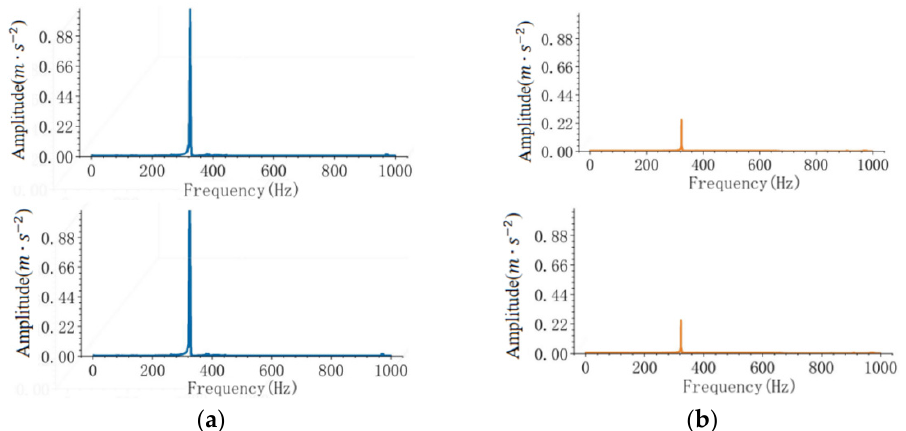
Figure 14. Sparse decomposition simulation amplitude/envelope results. ( a ) sparse decomposition amplitude map, and ( b ) sparse decomposition envelope spectrum.